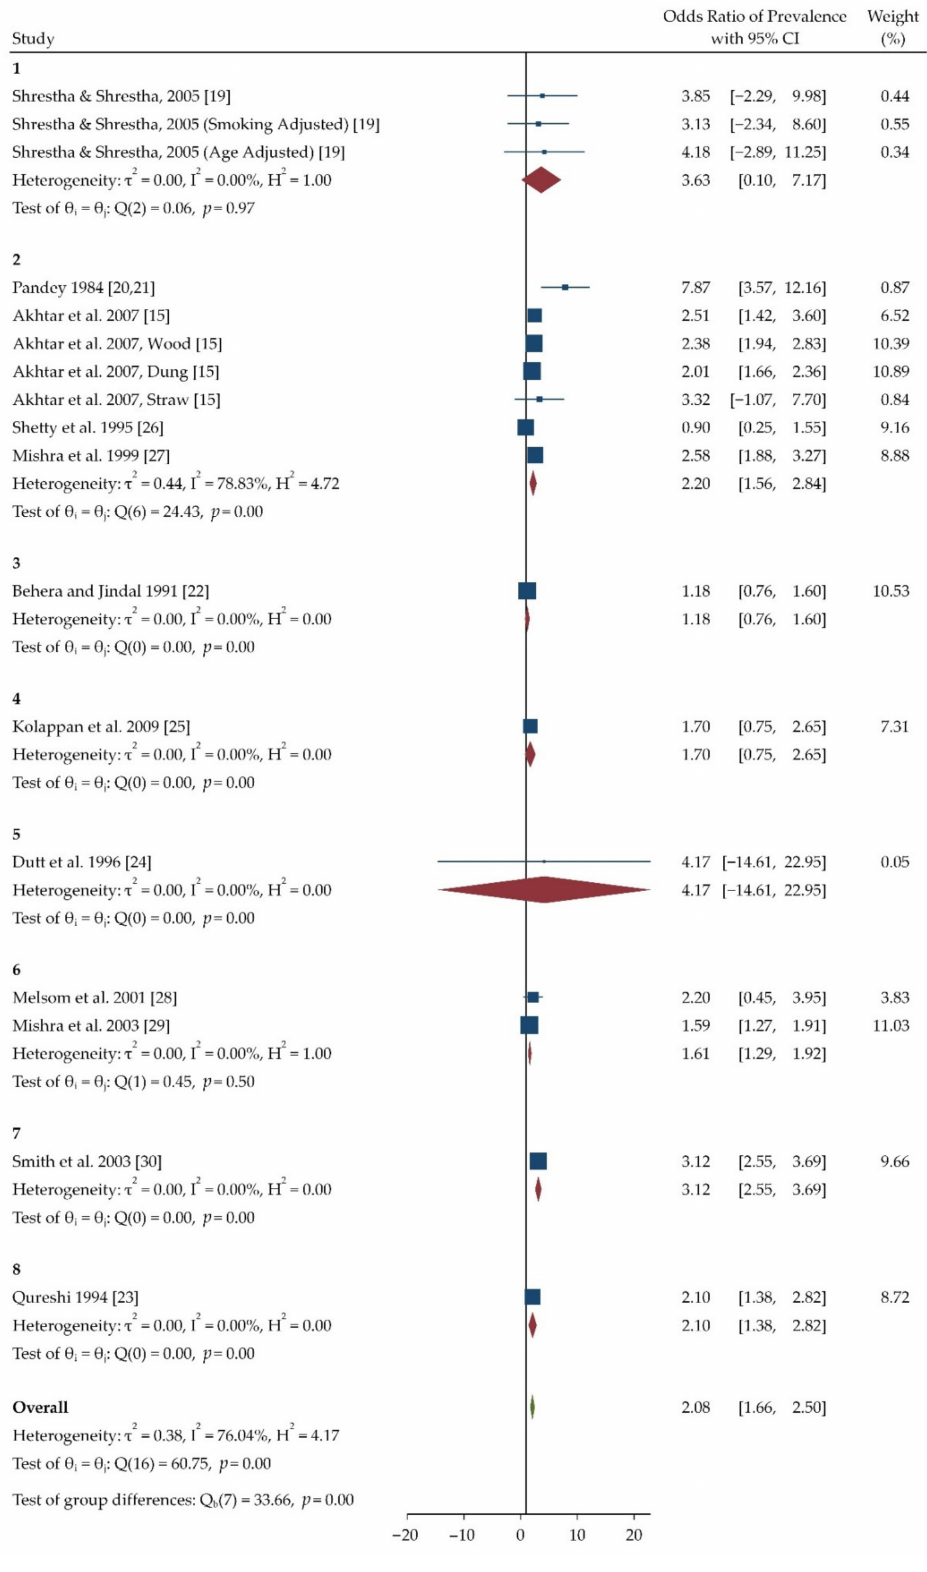
Figure 3. Forest plot of odd’s ratio for COPD prevalence. The plot has been generated using Random-effects Restricted maximum likelihood (REML) model. The forest plot has been given in terms of pollutant which have been assessed in respective studies. The number represents the pollutant which the studies have assessed, which is as follows: 1 = PM10, CO; 2 = Biomass; 3 = Biomass, LPG, Kerosene and Mixed; 4 = Kerosene; 5 = Biomass, LPG and Kerosene; 6 = Biomass and Clean Fuel; 7 = Kerosene and Biomass; 8 = Biomass and Mixed